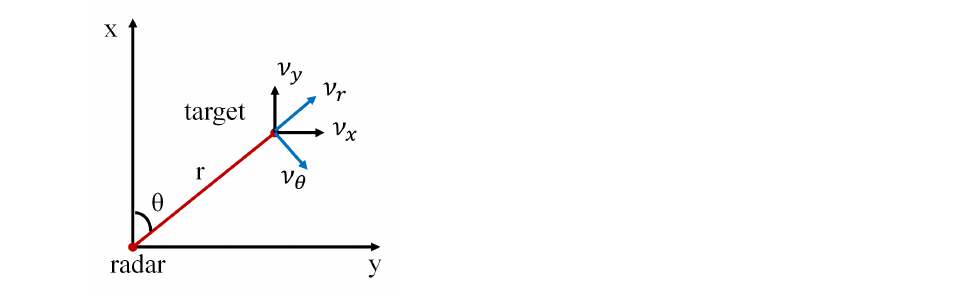
Figure A1. Geometric relationship between the target and the radar. According to (A12), the motion model (A11) in the polar coordinate system can be expressed as: